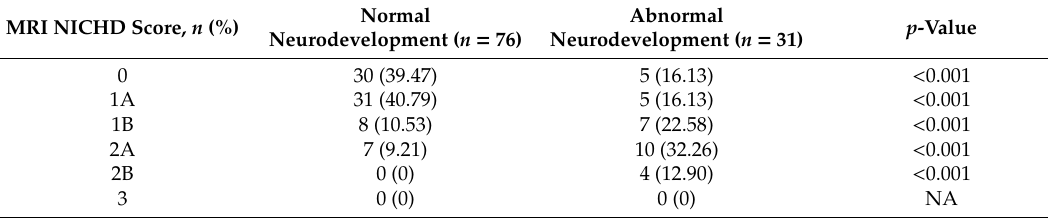
Table 2. Magnetic resonance imaging (MRI) findings according to the MRI NICHD Score ( n = 107). Normal Abnormal p -Value MRI NICHD Score, n (%) Neurodevelopment ( n = 76) Neurodevelopment ( n = 31)